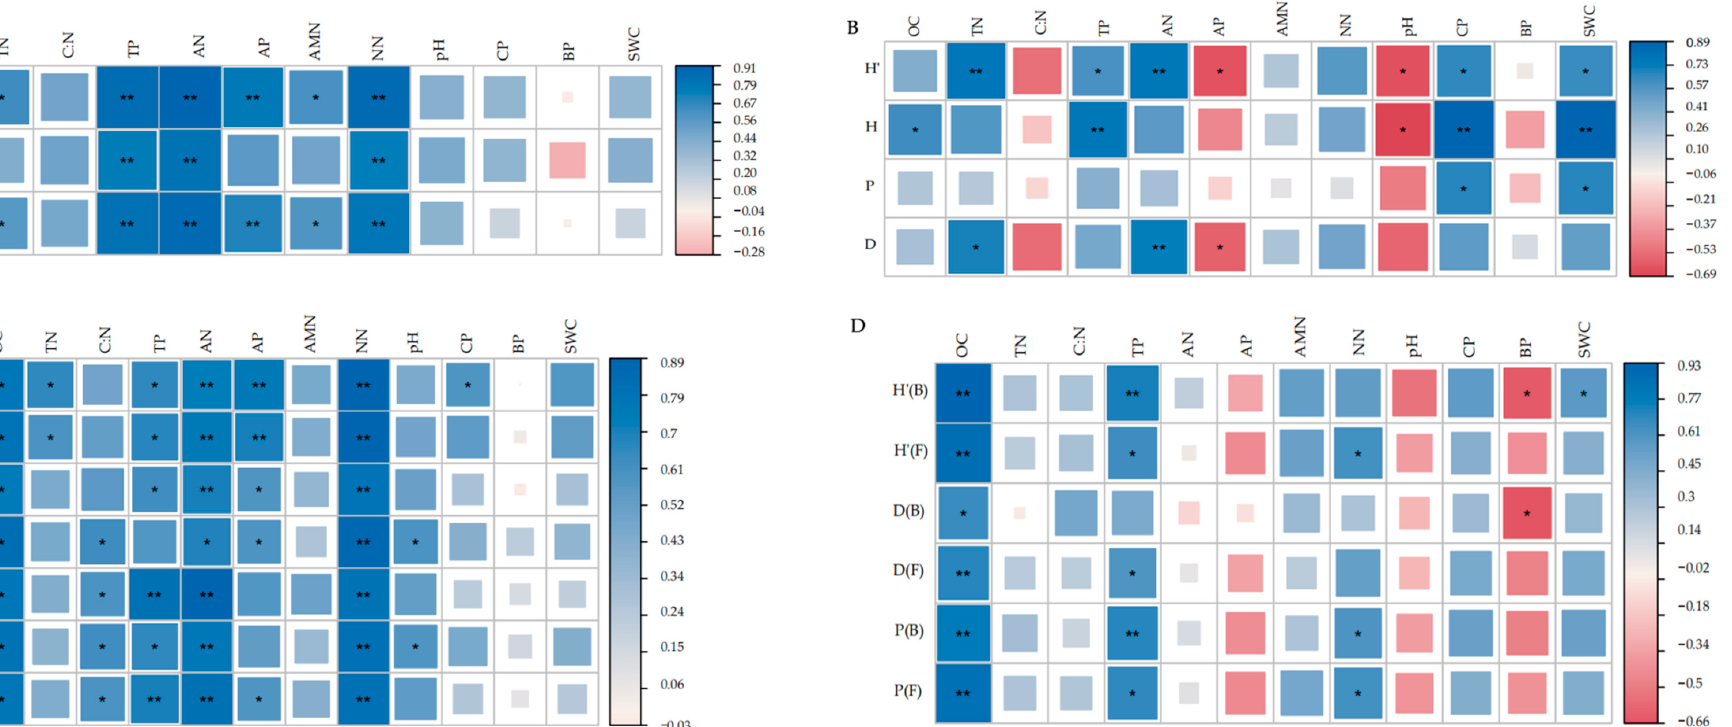
Figure 4. Correlation analysis between species diversity indices and single ecosystem functions in NF and CK. * p < 0.05, ** p < 0.01. ( A ), correlation analysis between plant diversity indices and single ecosystem functions in CK; ( B ), correlation analysis between plant diversity indices and single ecosystem functions in NF; ( C ), correlation analysis between bacterial diversity indices and single ecosystem functions in CK; ( D ), correlation analysis between bacterial diversity indices and single ecosystem functions in NF. H, H’, D, and P: Margalef index of the plant community, Shannon–Wiener index of the plant community, Simpson index of the plant community, and Pielou index of the plant community. C(F), P(F), H’(F), D(F), C(B), P(B), H’(B), and D(B): the Chao1 index of fungal community, Pielou index of fungal community, Shannon–Wiener index of fungal community, Simpson index of fungal community, Chao1 index of the bacterial community, Pielou index of the bacterial community, Shannon–Wiener index of the bacterial community, Simpson index of the bacterial community. OC, TN, C:N, TP, AN, AP AMN, NN, pH, CP, BP, and SWC: organic carbon, total nitrogen, C:N, total phosphorus, available nitrogen, available phosphorus, ammonia nitrogen, nitric nitrogen, pH, capillary porosity, bulk porosity, and soil water content.